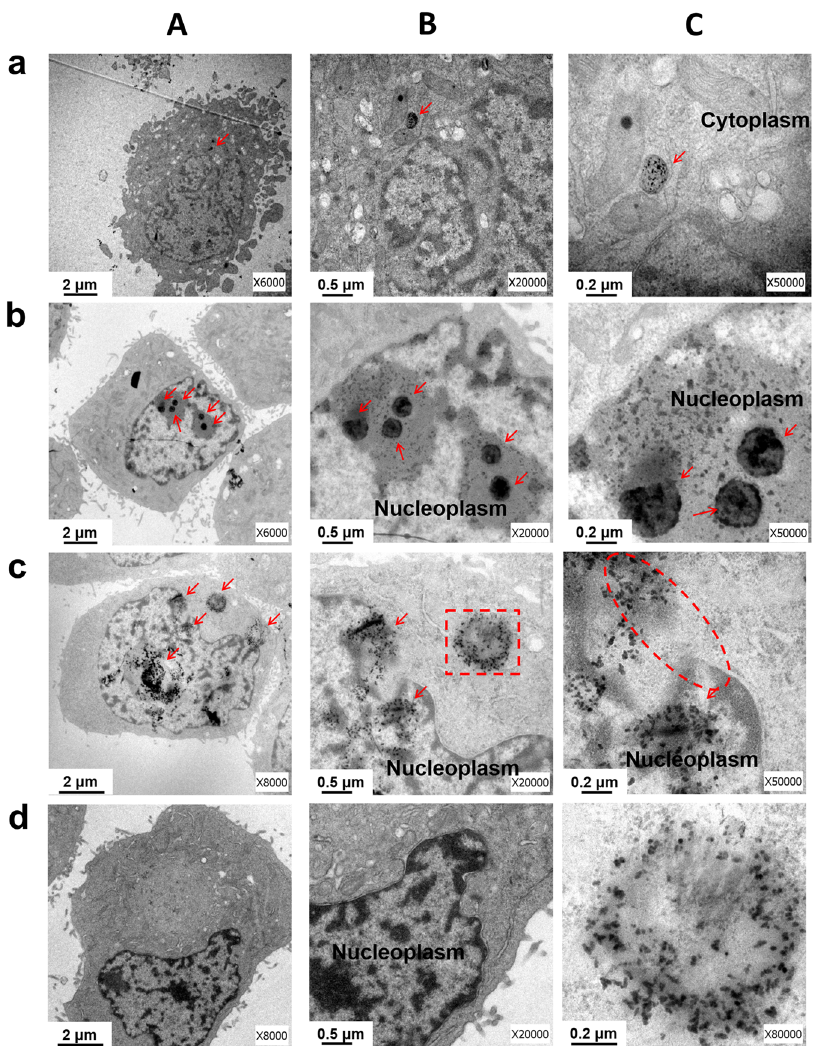
Fig. 4 TEM images of HeLa cells treated with NH-GQDs derivatives. a NH-GQDs, b TAT-NGs (10:1), and ( c ) FAPEG-TNGs for 24 h (the images are zoomed in on the same cell from A , B to C ; the red arrows show the NH-GQDs derivatives in the cells); dA , dB TEM images of HeLa cells without treatment; dC magni fi cation of the square part in ( cB ) to observe the dots in the cells.